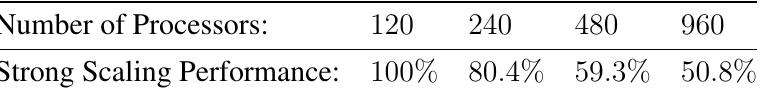
Table 3: Strong scaling performance of FETCH2 with energy dependent angular adapting discretisations and